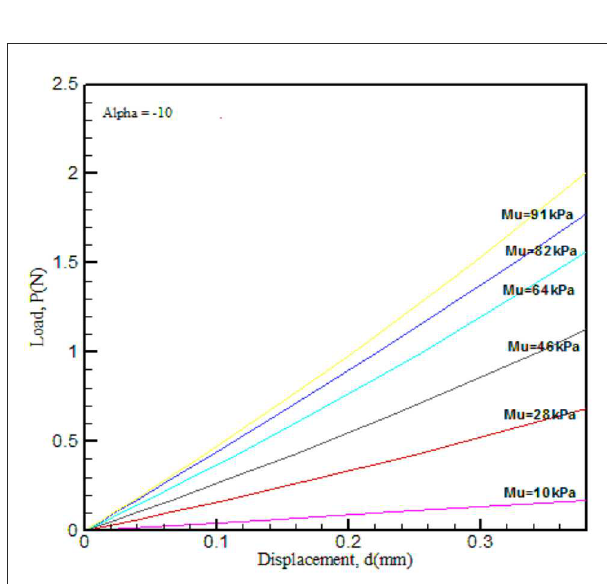
FIGURE7 FE-simulated load–displacement graph for the Ogden hyperelastic model. Material property α was varied and µ was kept